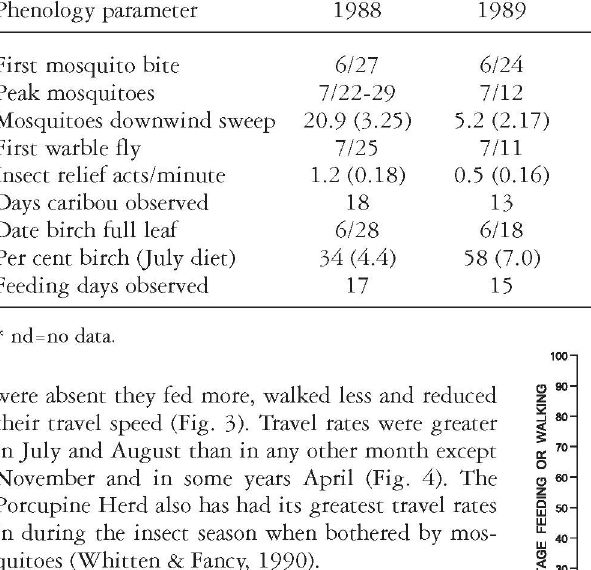
Table 3- Phenology dates (month/day) relative to summer energy budgets (1988-92). (Standard error of the mean in patenthesis).